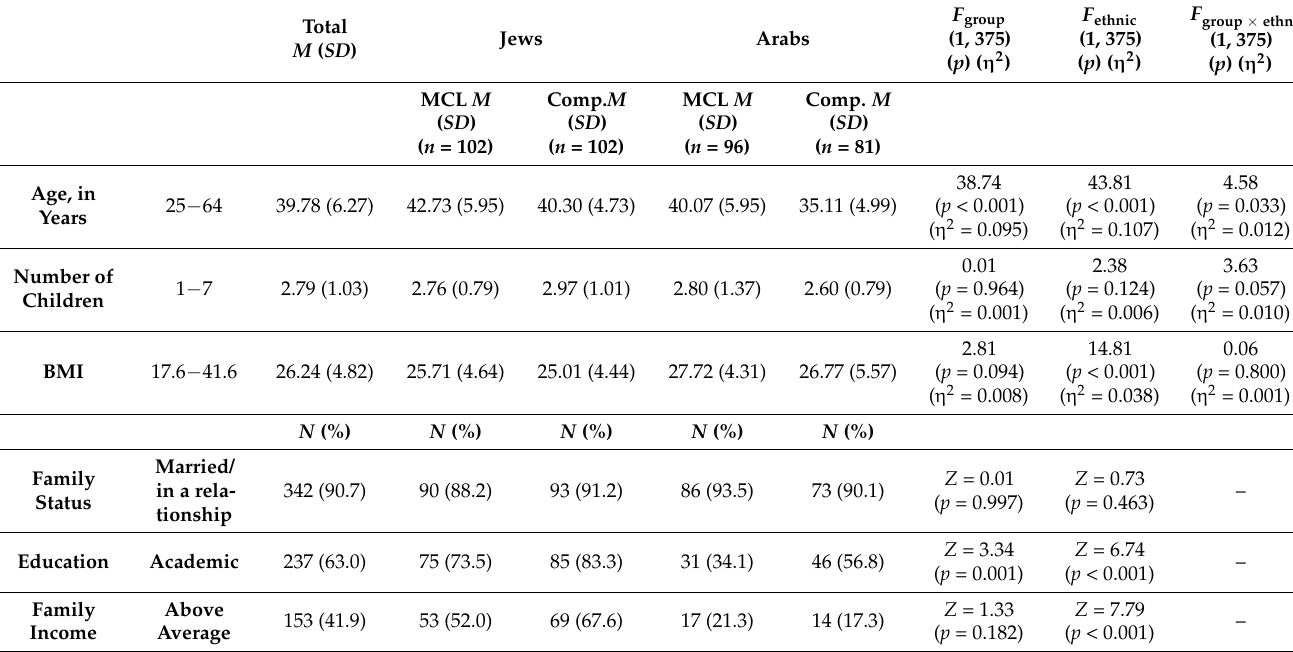
Table 1. Background characteristics according to ethnicity and group ( n =